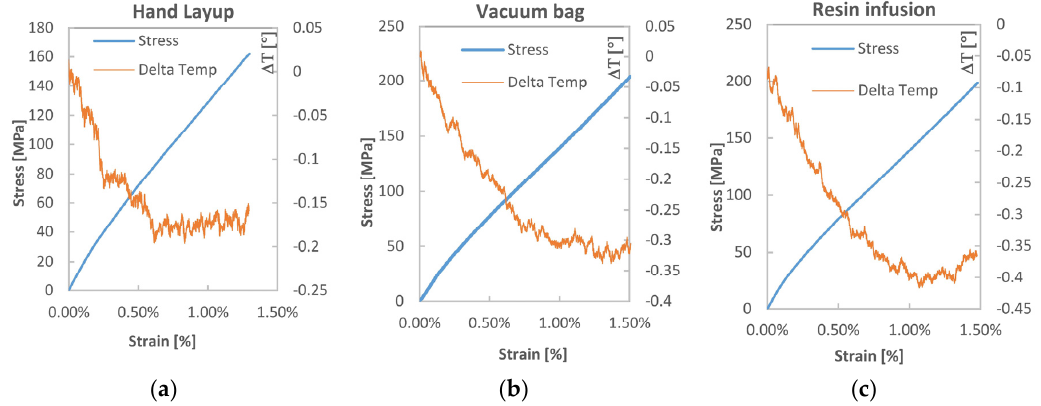
Figure 10. Evolution of temperature during monotonic tensile tests overlapped to the stress strain curves for for the: ( a ) hand lay ‐ up, ( b ) vacuum bag and ( c ) resin infusion laminated composites .